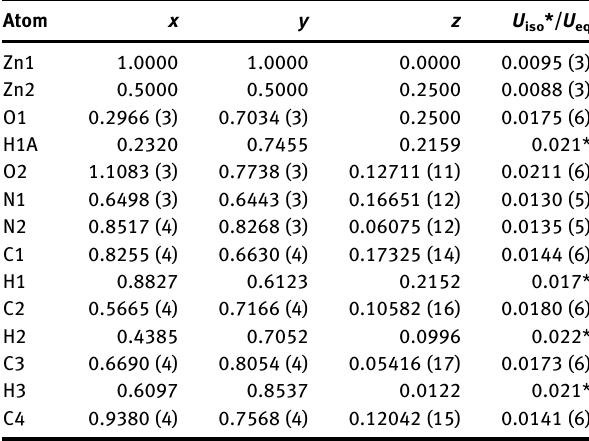
Table  : Fractional atomic coordinates and isotropic or equivalent isotropic displacement parameters (Å 